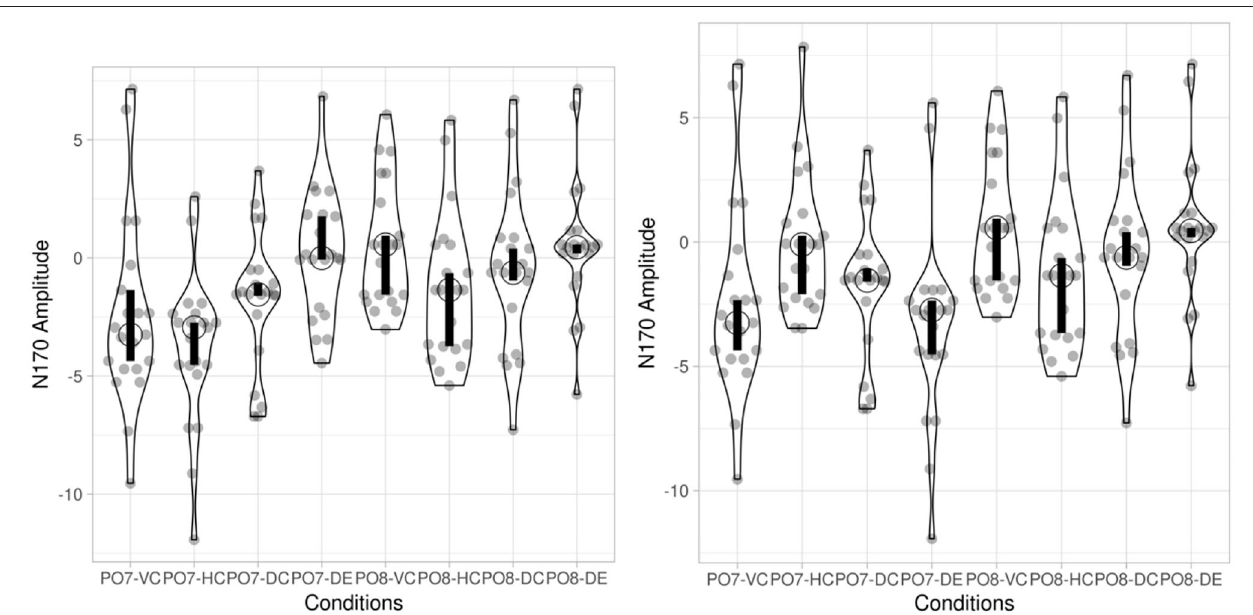
FIGURE 5 | N170 amplitude of normal readers (left) and dyslexic readers (right) in VC, HC, DC and DE condition. Open circle indicates the median of the data. Bar chart indicates the 95% confidence interval for each median determined by bootstrapping. (VC, viewing-Chinese; HC, handwriting-Chinese; DC, drawing followed by Chinese recognition; DE, drawing followed by English recognition).